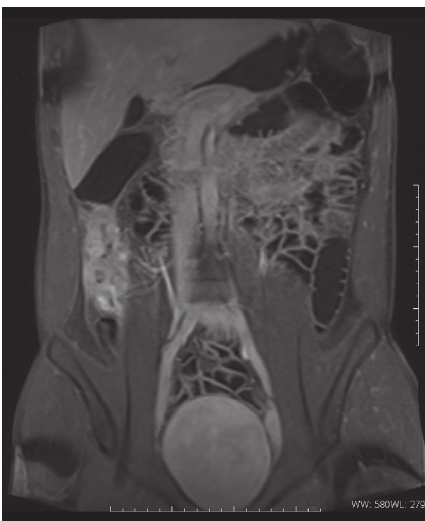
Figure 1: Coronal t1-weighted MRI image with the gadolinium contrast agent, presenting wall thickening and enhancement of the caecum and proximal ascending colon.